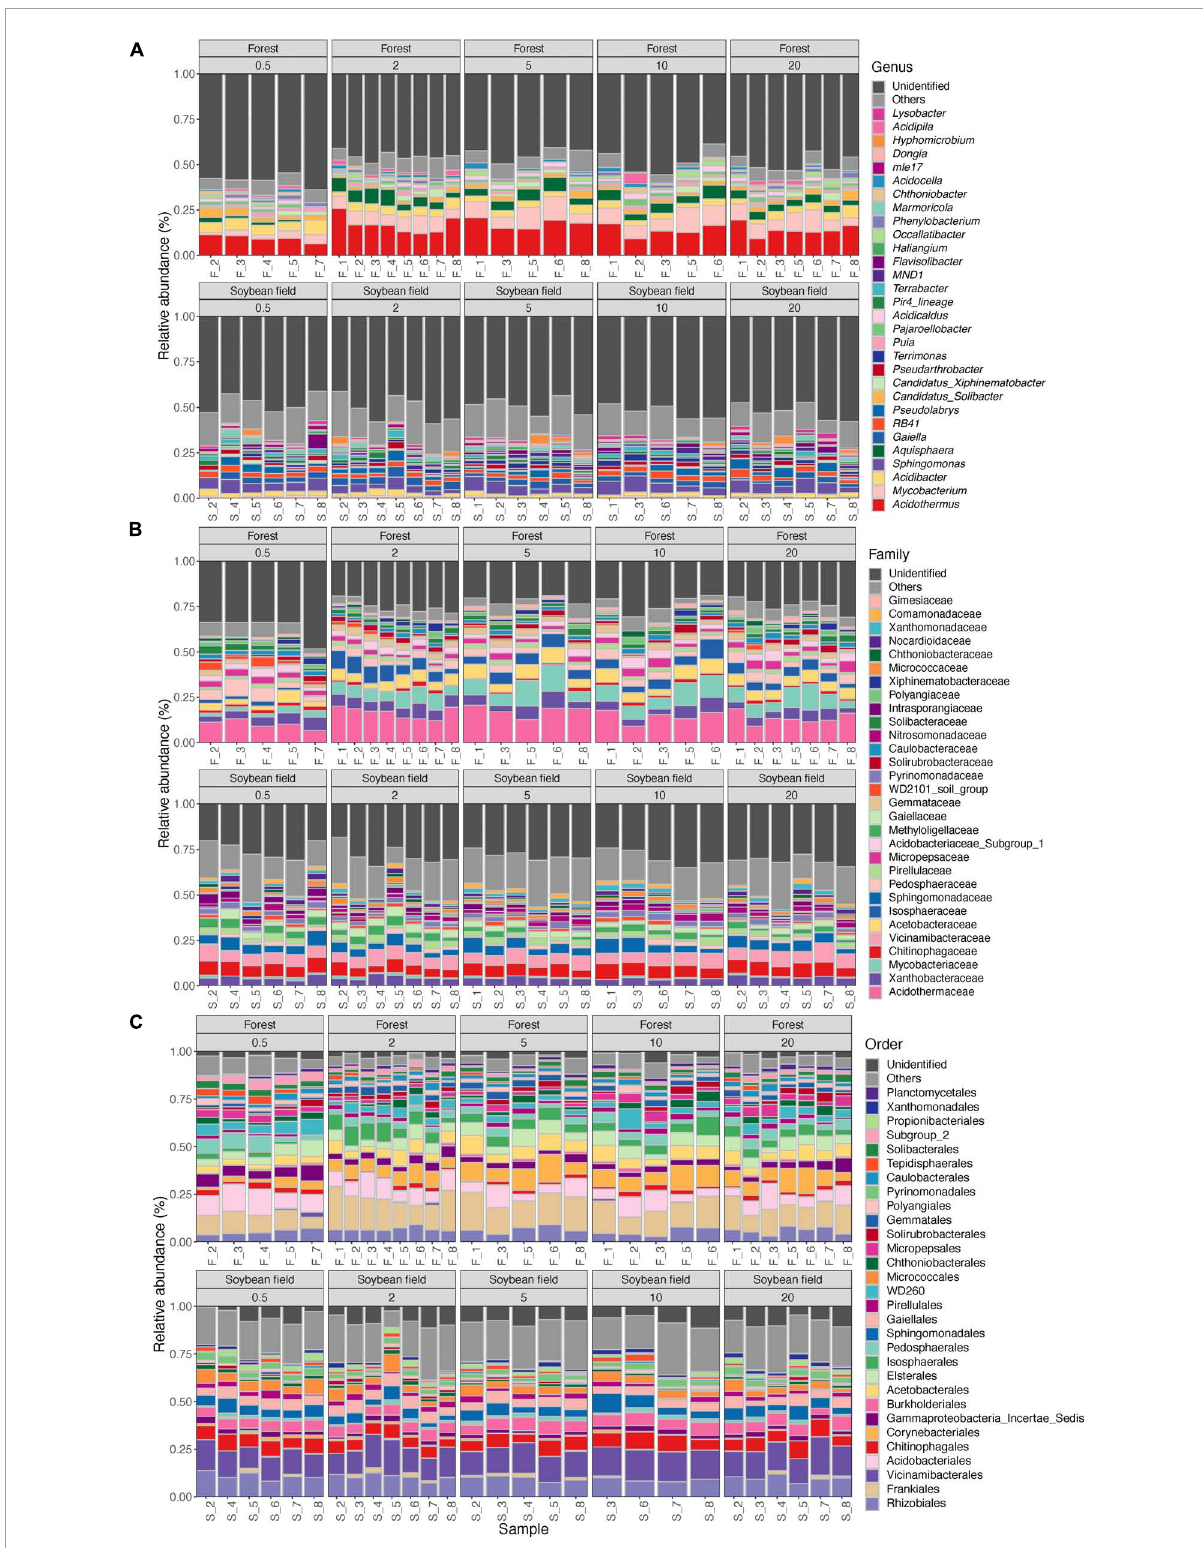
FIGURE2 Community compositions of bacteria at the genus (A) , family (B) , and order (C) levels. The alphabets indicating source ecosystem type (“F_,” forest; “S_,” soybean field) are followed by replicate sample numbers. Samples with less than 1,000 sequencing reads were omitted.